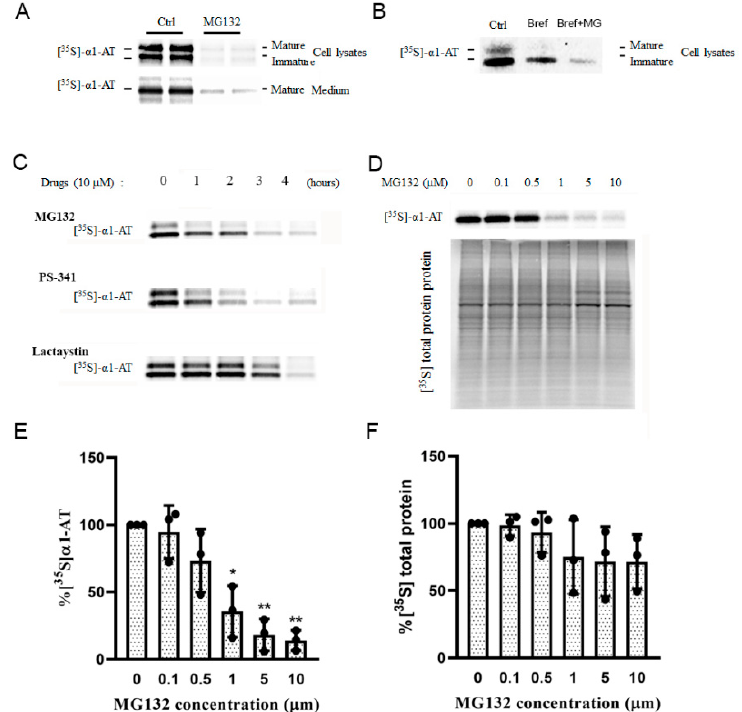
Figure 3. Proteasome inhibitors inhibited α 1AT synthesis in hepatocytes. ( A ) C3A cells were subjected to none or 10 µ m MG132 treatment for 4 h and then labeled with [ 35 S] methionine / cysteine for 30 min; ( B ) Brefeldin A (2 µ g / mL) was added to the medium. α 1AT was immunoprecipitated from cell lysates and [ 35 S] labeled α 1AT was detected by autoradiography. ( C ) C3A cells were incubated with 10 µ m of MG132, PS-341 and Lactacystin for di ff erent time points (0 to 4 h) and the cells were labeled with [ 35 S] methionine / cysteine for additional 30 min. α 1AT was immunoprecipitated from cells lysates and culture media. Eluted proteins were analyzed by SDS-PAGE and [ 35 S] labeled α 1AT was detected by autoradiography. ( D ) C3A cells were incubated with di ff erent concentration of MG132 for 4 h. Cell were then labeled with [ 35 S] methionine / cysteine for 15 min. [ 35 S] labeled α 1AT and general protein were detected by autoradiography. Isotope labelled α 1AT ( E ) and total protein ( F ) were quantitatively analyzed; data represent means ± SD of three independent experiments. * p < 0.05; ** p < 0.001.